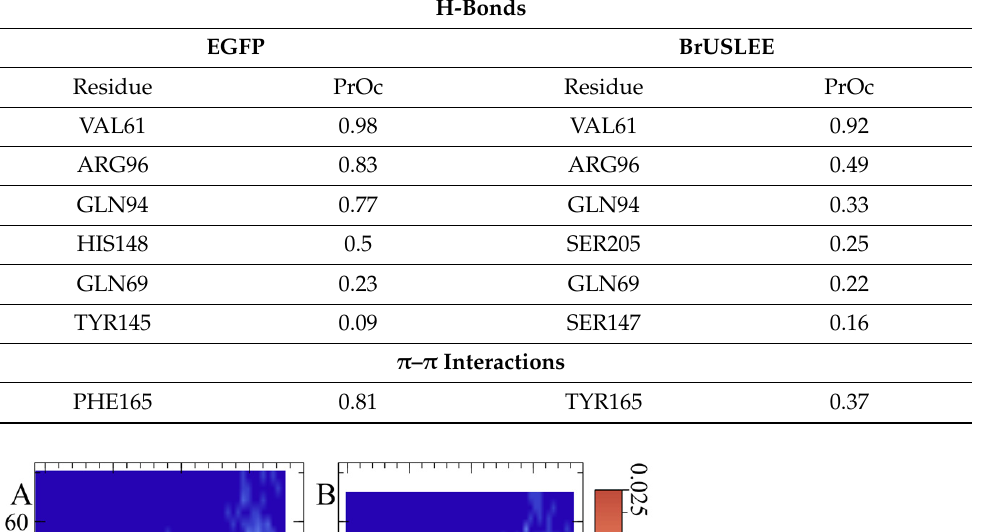
Table 4. Probability of occurrence (PrOc) of H-bonds and π – π interactions in the chromophore areas.